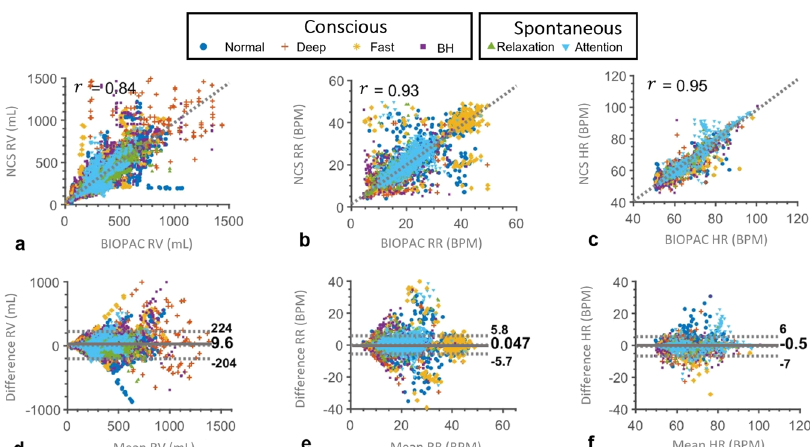
Fig. 3 Correlation and agreement between NCS and BIOPAC estimate of RV, RR, and HR over the entire data. The label shows a marker for each breathing style, including conscious normal, deep, fast and breath-hold (BH), as well as spontaneous breathing in relaxation and attention states. a – c Scatter plots of NCS vs. BIOPAC RV, RR, and HR, respectively, with denoted Pearson ’ s correlation coef fi cient, r , showing a high correlation between the two sensors. d – f B & A plots of NCS and BIOPAC showing the bias m at the center (solid line) and the corresponding LoA (dotted lines) given by m ±1 : 96 (cid:1) σ . Table 1. Correlation and B & A statistics.